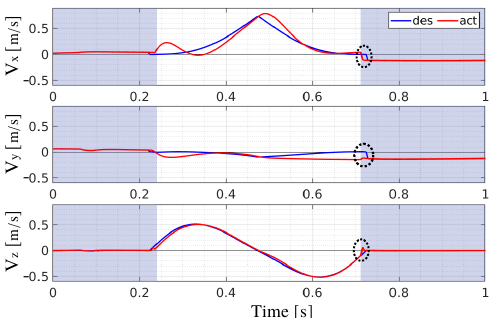
Figure 4. Desired (blue line) and actual (red line) foot velocity in a simulation task of crawling (no slippage). Velocity v = [ v x v y v z ] is expressed wrt B . The shaded areas indicate that the foot is in stance.